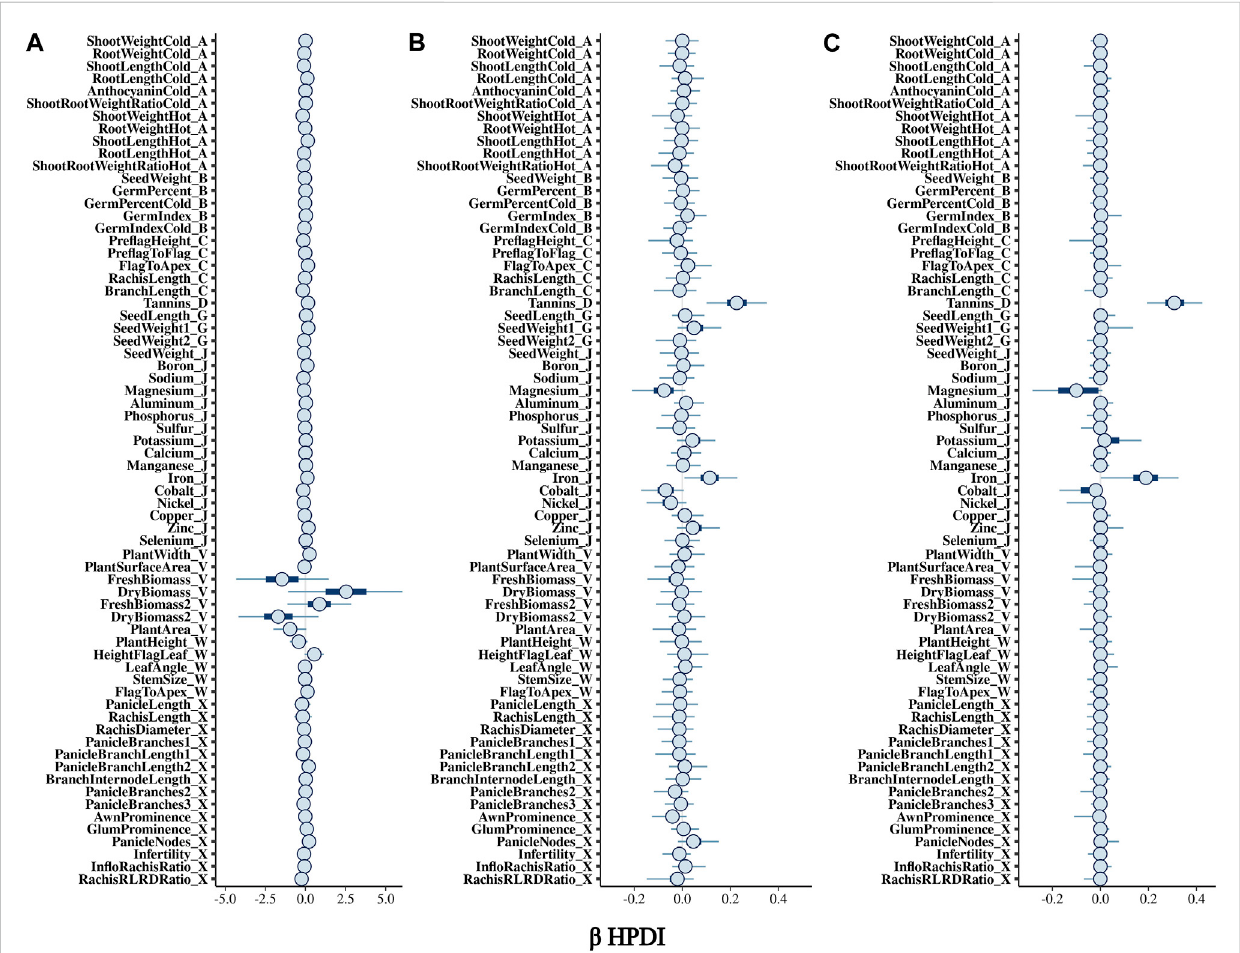
FIGURE 1 Posterior estimates of β for traits associated with Tan2 (Chr2:7,976,118) using (A) Bayesian Ridge, (B) Lasso, and (C) Horseshoe Regression. Boxplots represent the 95% highest posterior density interval (HPDI) based on MCMC